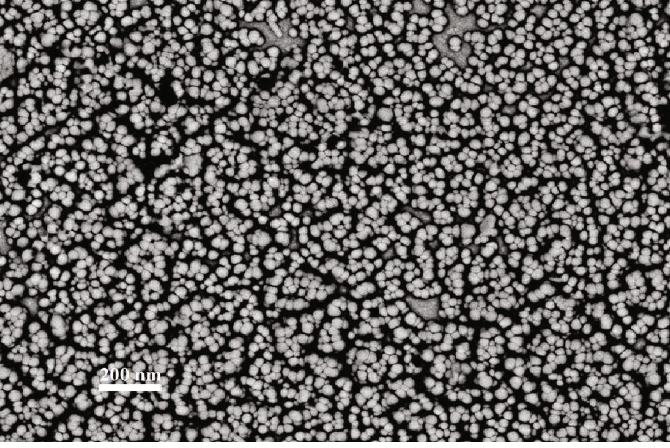
Figure 3: SEM image of synthesis of Se